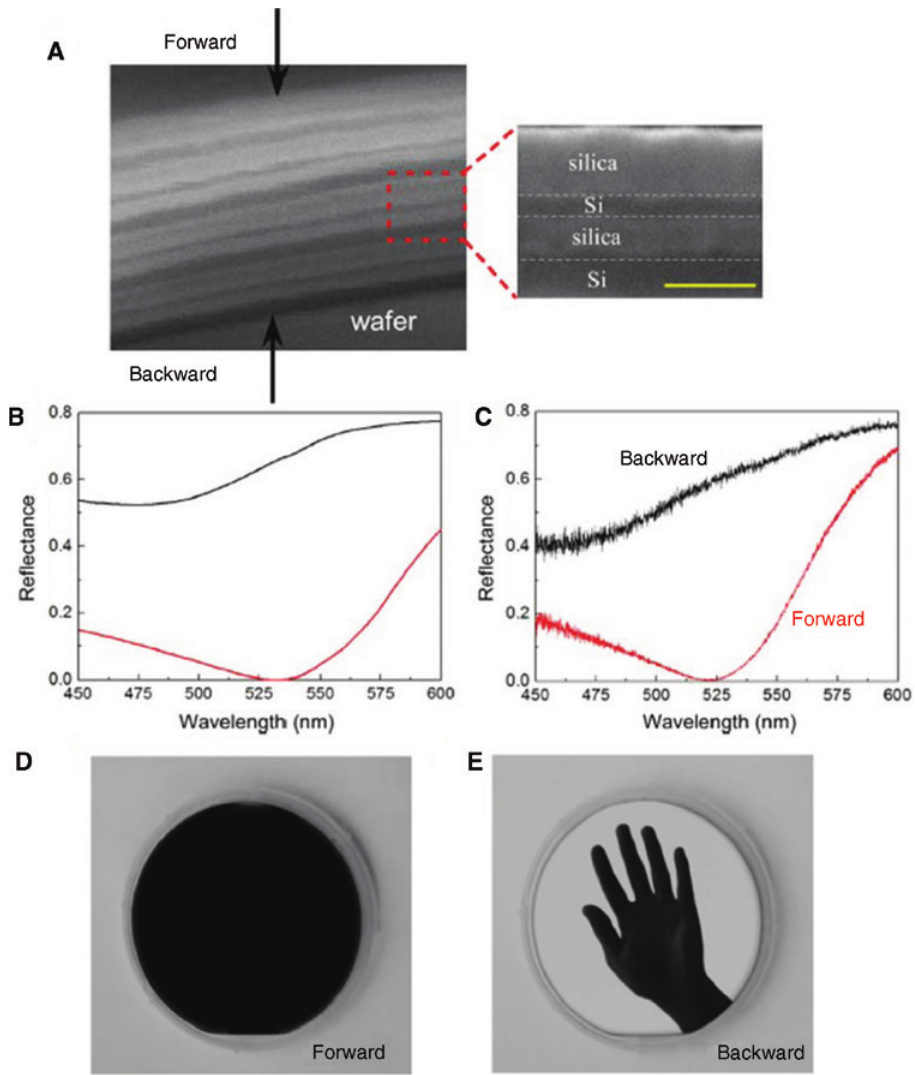
Figure 8: Unidirectional reflectionlessness of a non- PT -symmetric large-sized nonperiodic multilayer structure consisting of lossy amor- phous silicon and lossless silica layers. (A) SEM pictures of the cross-section of the fabricated EP structure. The scale bar corresponds to 50 nm. (B and C) Numerically calculated and experimentally measured reflection spectra of the EP structure from 450 to 600 nm, respectively, for both forward (red) and backward (black) incidence. (D and E) Photographs of the wafer-scale EP structure in forward and backward directions, respectively, with a 10-nm band-pass filter centered at the wavelength of 520 nm